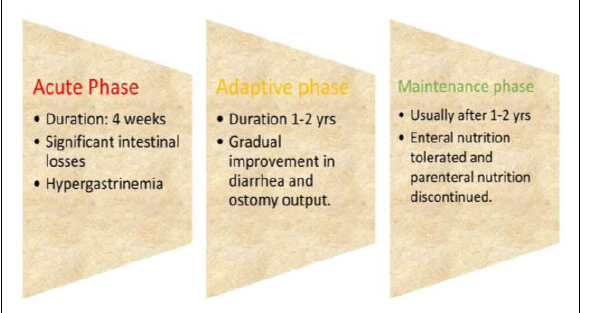
Figure 1: Clinical course of patients with